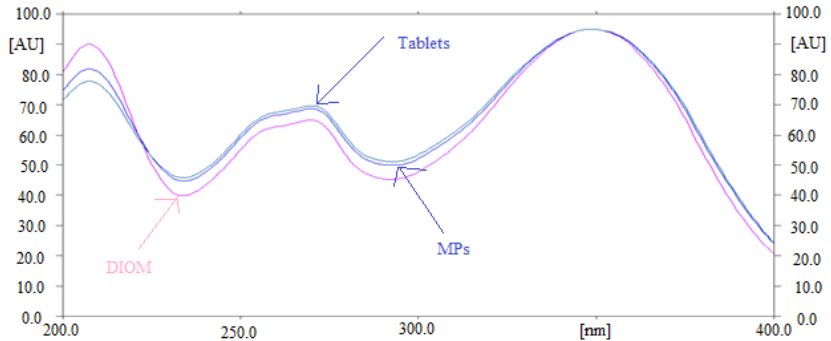
Figure 3. Overlaid ultra-violet (UV) absorption spectra of standard DIOM, commercial tablets and in-house developed spray-dried microparticles (MPs).